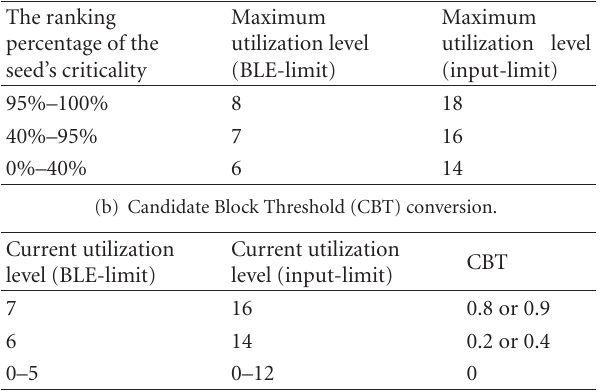
Table 5: Conversion of parameters for input-limit strategy. (a) Maximum Utilization Table (MUT)